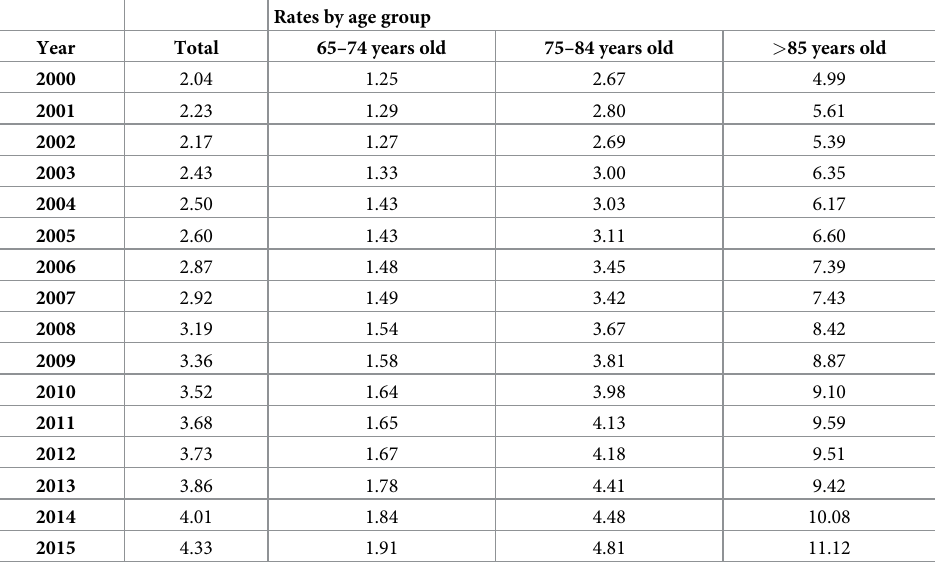
Table 2. Hospitalization rates from 2000 to 2015 globally and by age group.